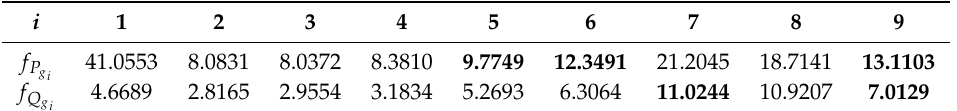
Table 6. Minimum values of the 18 performance indices achievable by the four-parameter controllers of design concept 2. The five performance indices for which concept 2 does not reach the minimum values attainable by concept 1 are highlighted in